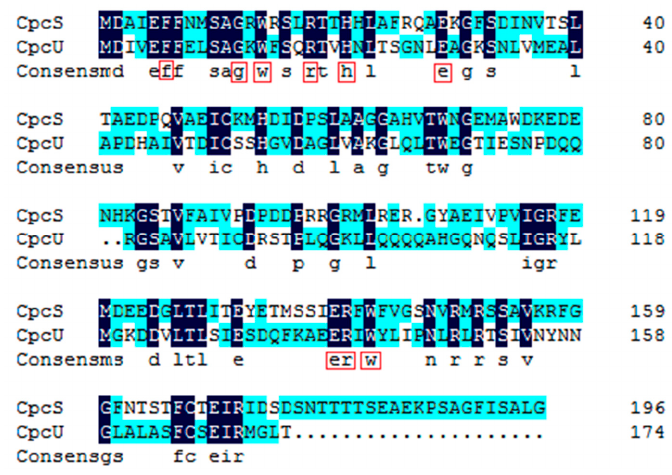
Figure 5. The sequence alignment of CpcS and CpcU of A. platensis FACHB314.